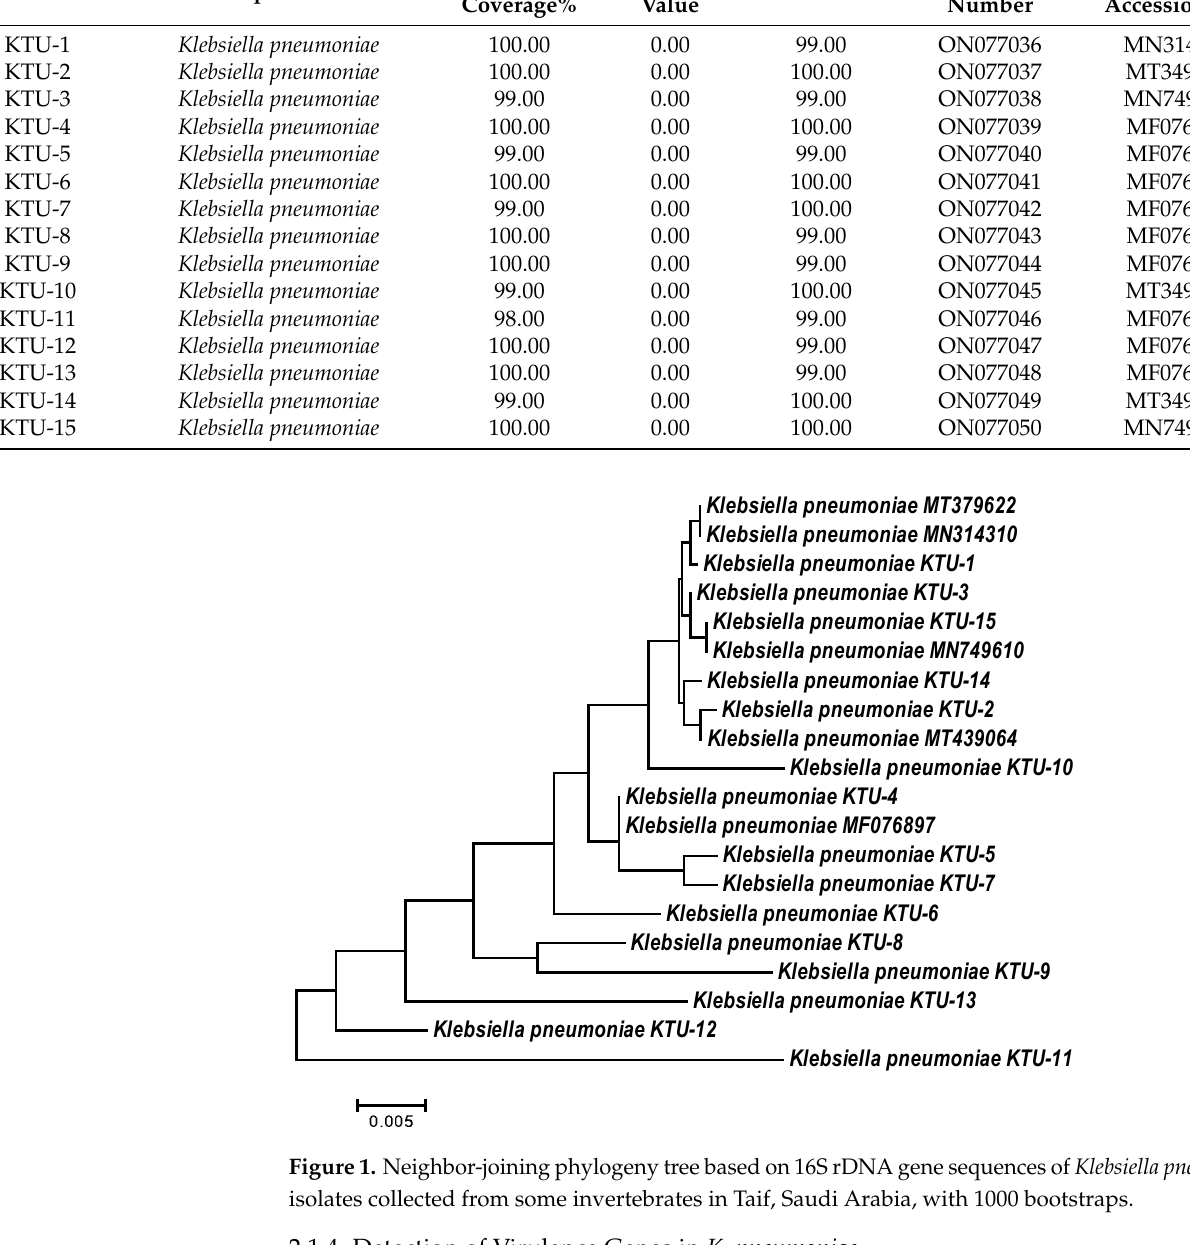
Table 2. NCBI BLAST query for Klebsiella pneumoniae isolated from invertebrates in Taif, Saudi Ara- bia.